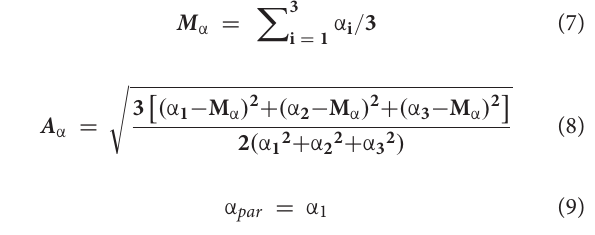
( Table 1 ). A mono-exponential model for DW signal decay was used (Basser and Jones,